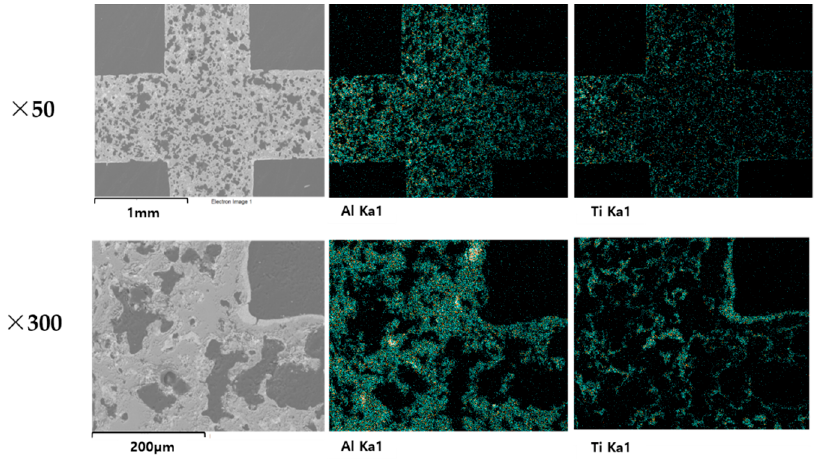
Figure 1. SEM image of catalyst.